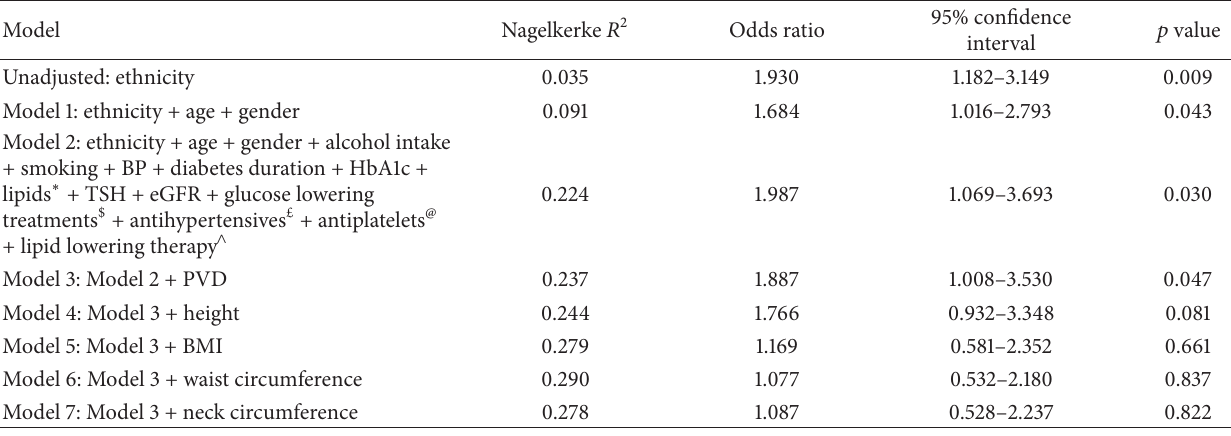
Table 3: Assessing the impact of possible confounders on the association between ethnicity and DPN (based on MNSI) using logistic regression models with increasing complexity. The odds ratios reported are the odds for having DPN in White Caucasians to South Asians. BP: blood pressure; eGFR: estimated glomerular filtration rate; PVD: peripheral vascular disease; BMI: body mass index.